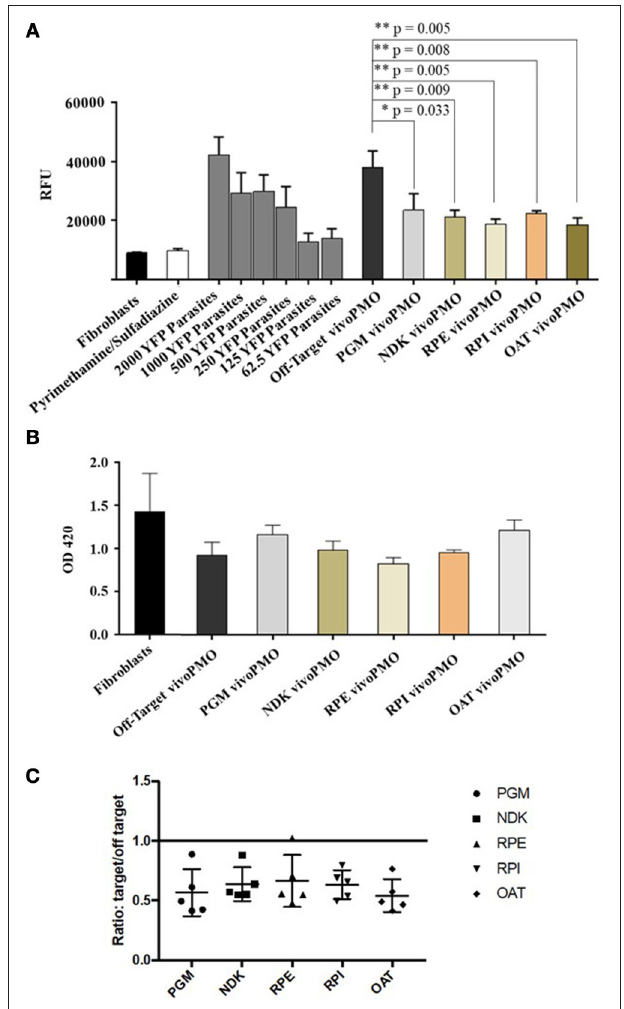
FIGURE 8 | (A) YFP/vivoPMO Efficacy Assay at 10 µ M. Targeted vivoPMOs show statistically significant knockdown relative to off-target and to a standardized parasite concentration as determined by student t -test. (B) Wst-1 Cell Viability/ vivoPMO Toxicity Assay at 10 µ M. Targeted vivoPMOs do not show statistically significantly ( p < 0.05 by student T -test) different levels of optical density relative to off-target vivoPMO or uninfected fibroblasts at 10 µ M concentrations. (C) Ratio of On- to Off-Target vivoPMO for Replicate Experiments Using 10 µ M of Targeted vivoPMO. The data presented here represent five replicate experiments. Lower individual values suggest a larger effect of the